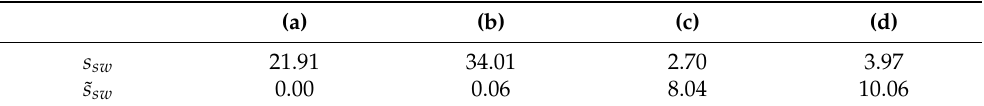
Table 1. The values of s sw and ˜ s sw